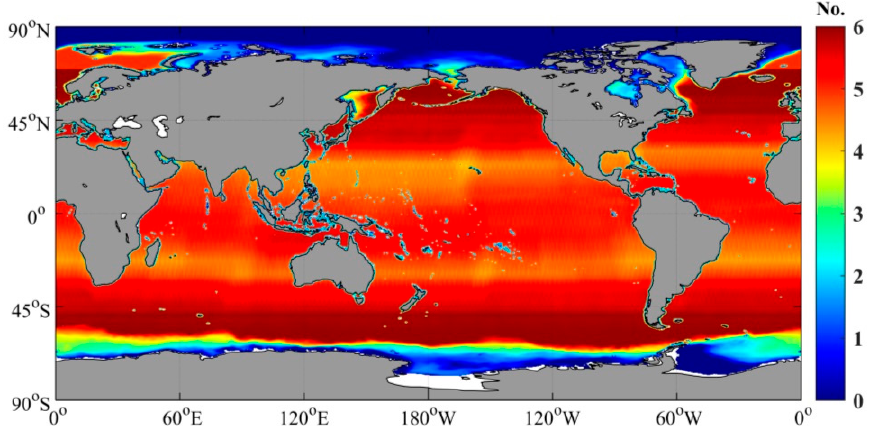
Figure 6. Number of effective observations of multisource spaceborne radiometer water vapor data of 2018. This figure is expressed using the daily average data calculated by using the effective water vapor observation data of spaceborne radiometers in 2018.